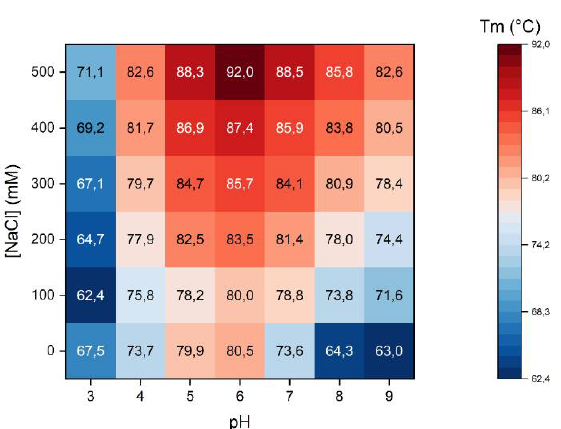
Figure 3. β-vignin melting temperature matrix plot. Each box of the graphical representation reports the calculated melting temperature of the protein at given pH and NaCl concentrations. Values are reported in °C degrees; color code is reported on the right.